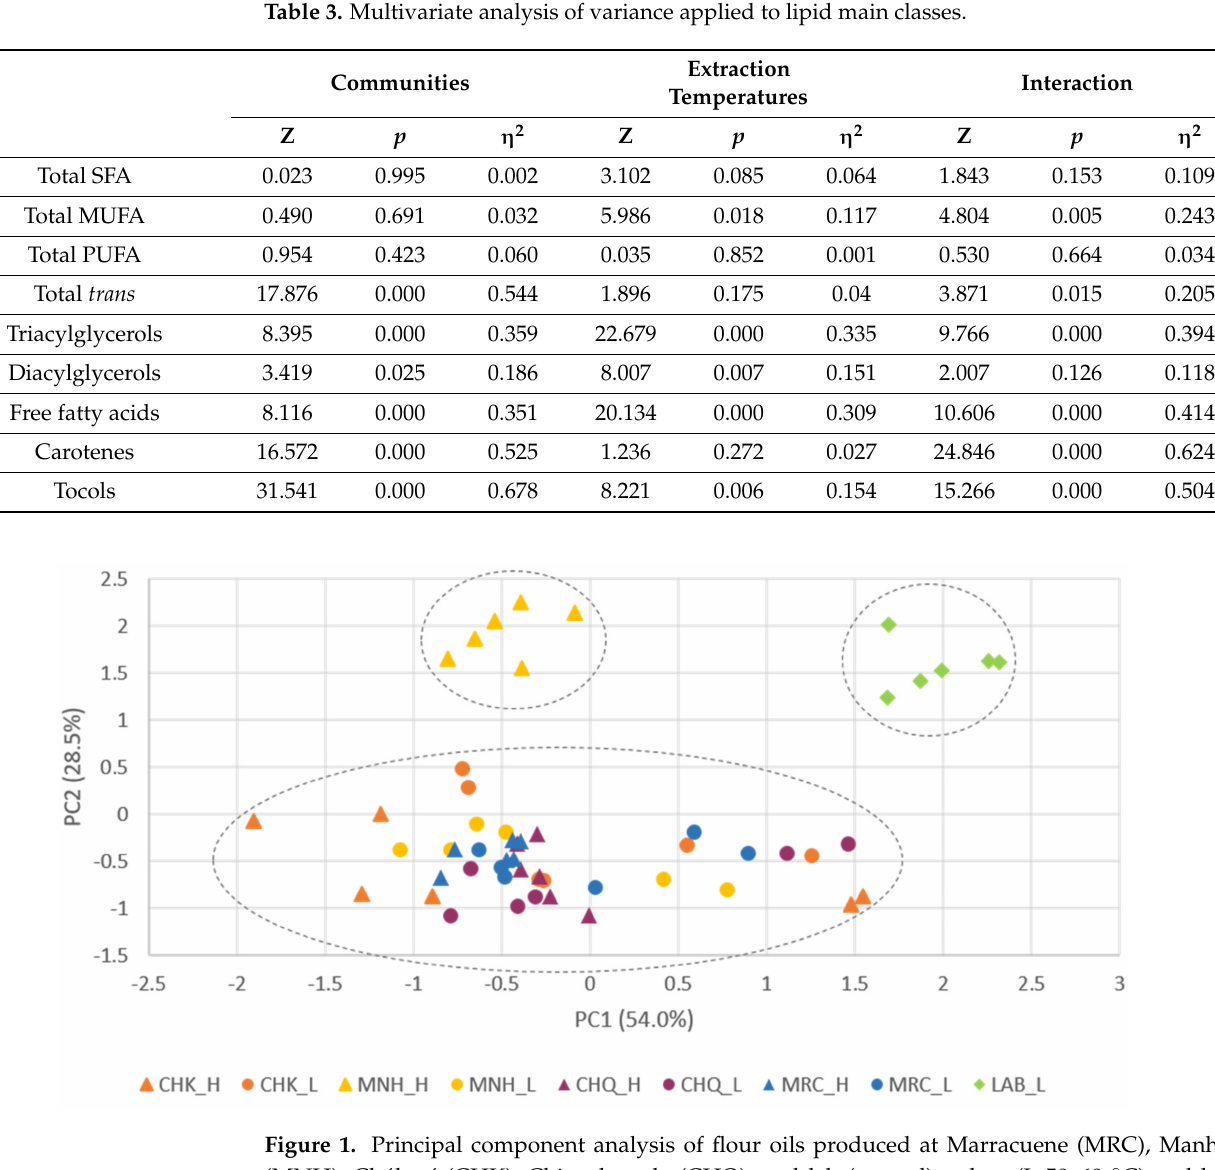
Figure 1. Principal component analysis of flour oils produced at Marracuene (MRC), Manhiça (MNH), Ch ó kw é (CHK), Chicualacuala (CHQ), and lab (control) at low (L 50–60 ◦ C) and high (H 60–70 ◦ C)